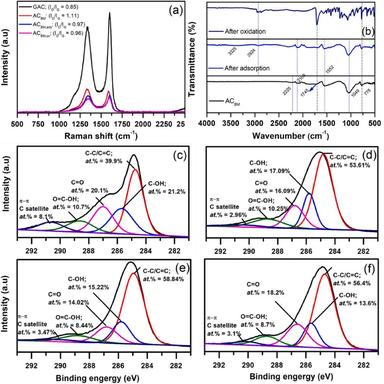
Surface analysis of catalyst materials GAC and ACBM: (a) Raman spectra of GAC and ACBM before and after oxidation; (b) FT-IR analysis of ACBM; XPS spectra C 1s of (c) GAC (initial); (d) ACBM (initial); (e) after sorption of ACBM; and (f) after oxidation of ACBM.